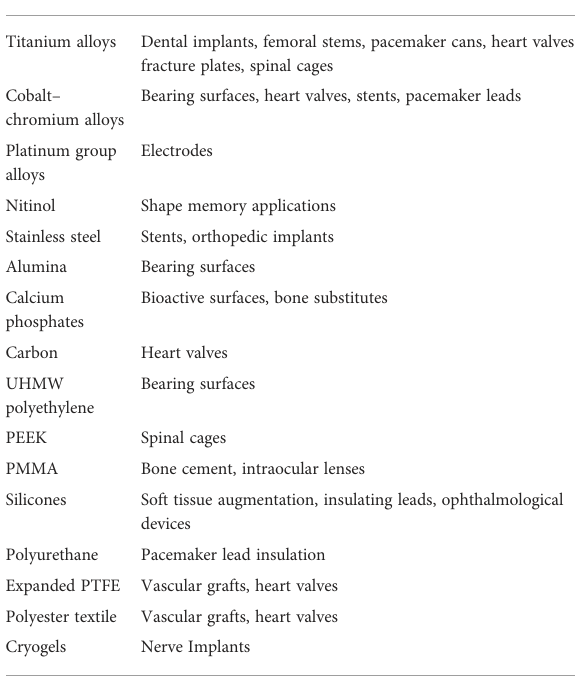
TABLE 2 State-of-the-art materials for long-term